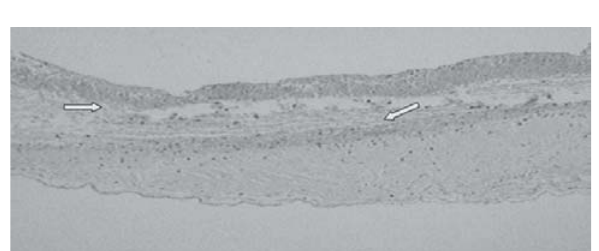
Fig. 5 - Fotomicrografia mostrando corte transversal da cúspide do heteroenxerto valvar pulmonar porcino, tratado com etanol, sem sinais de calcificação após 210 dias de implante (von Kossa 40X)